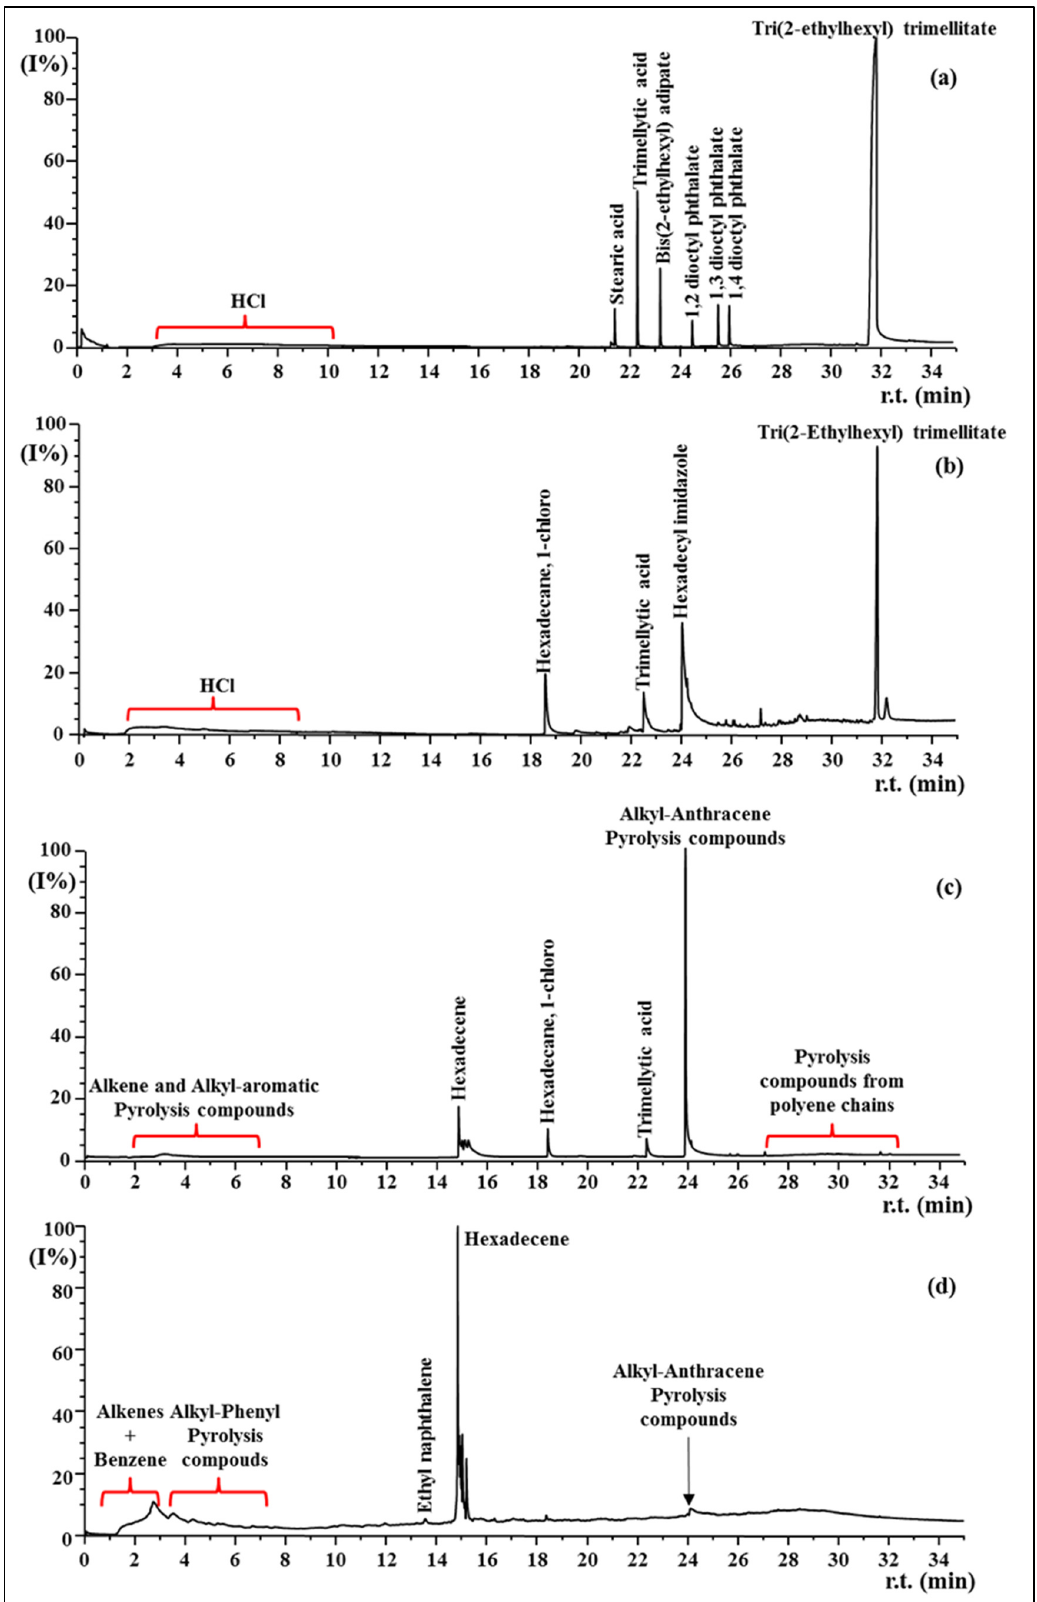
Figure 11. Py-GCMS pyrograms of the thermal products of the PVC/10% HdmimDMSIP blend